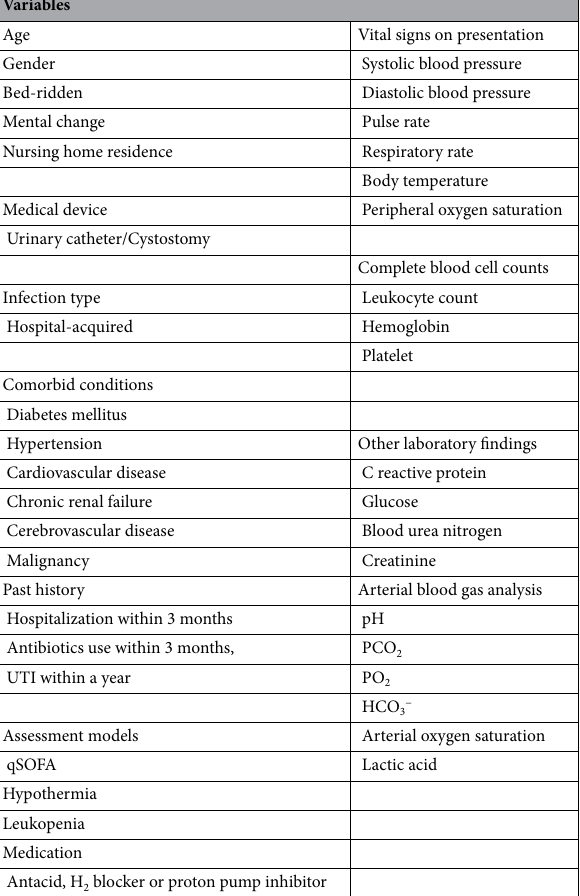
Table 1. Thirty-nine variables used to train the predictive